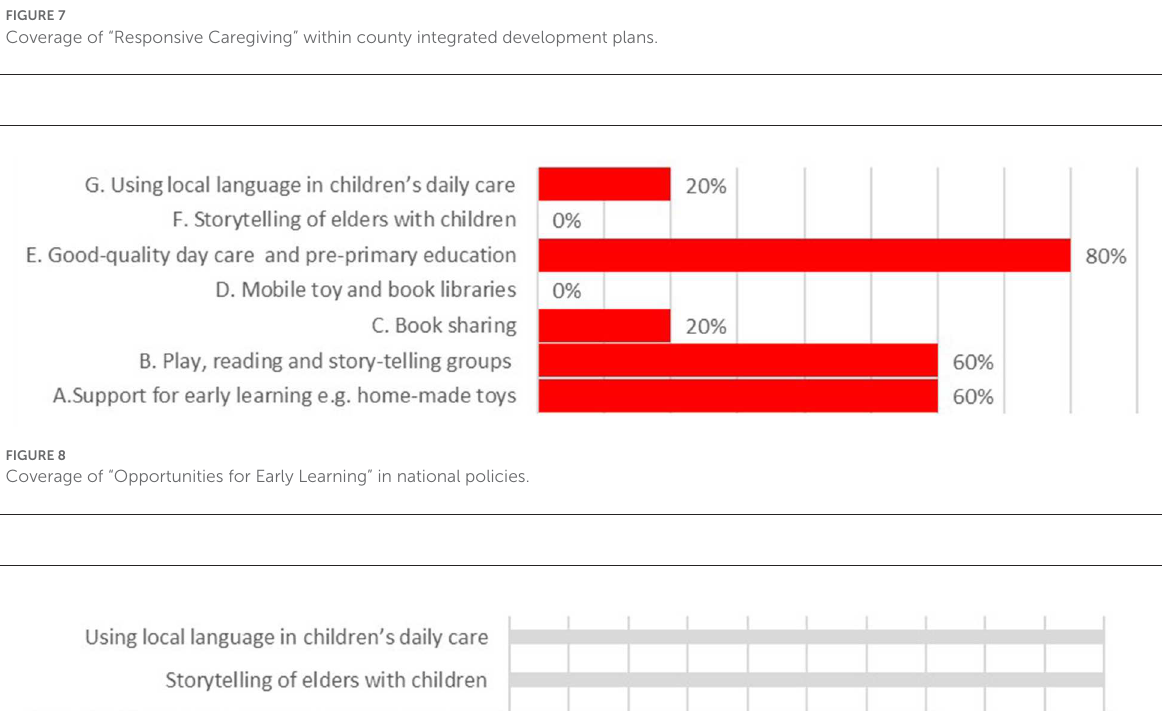
FIGURE7 Coverage of “Responsive Caregiving” within county integrated development plans.